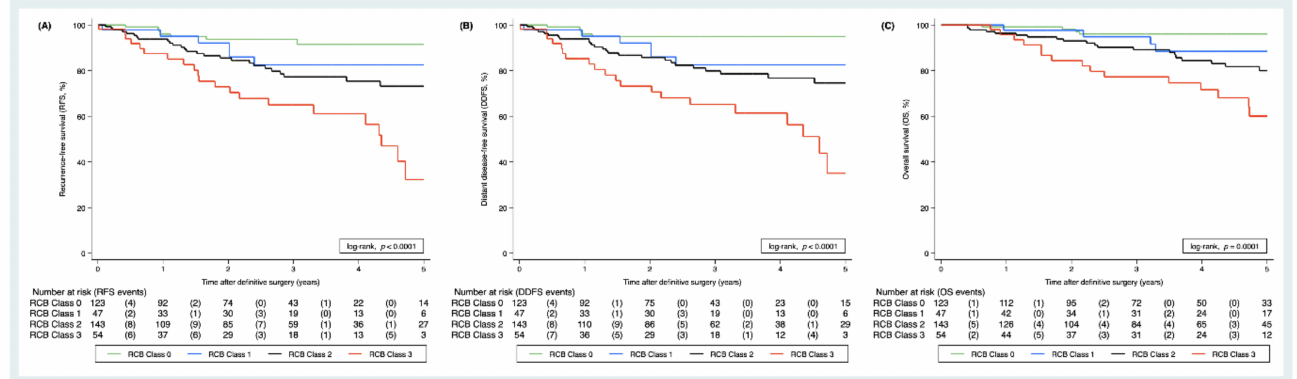
Figure 2. Kaplan–Meier RFS ( A ), DDFS ( B ), and OS ( C ) functions by RCB class. The numbers below the Kaplan–Meier plot form a risk table, whereas the round brackets contain the number of events occurring within the respective report.